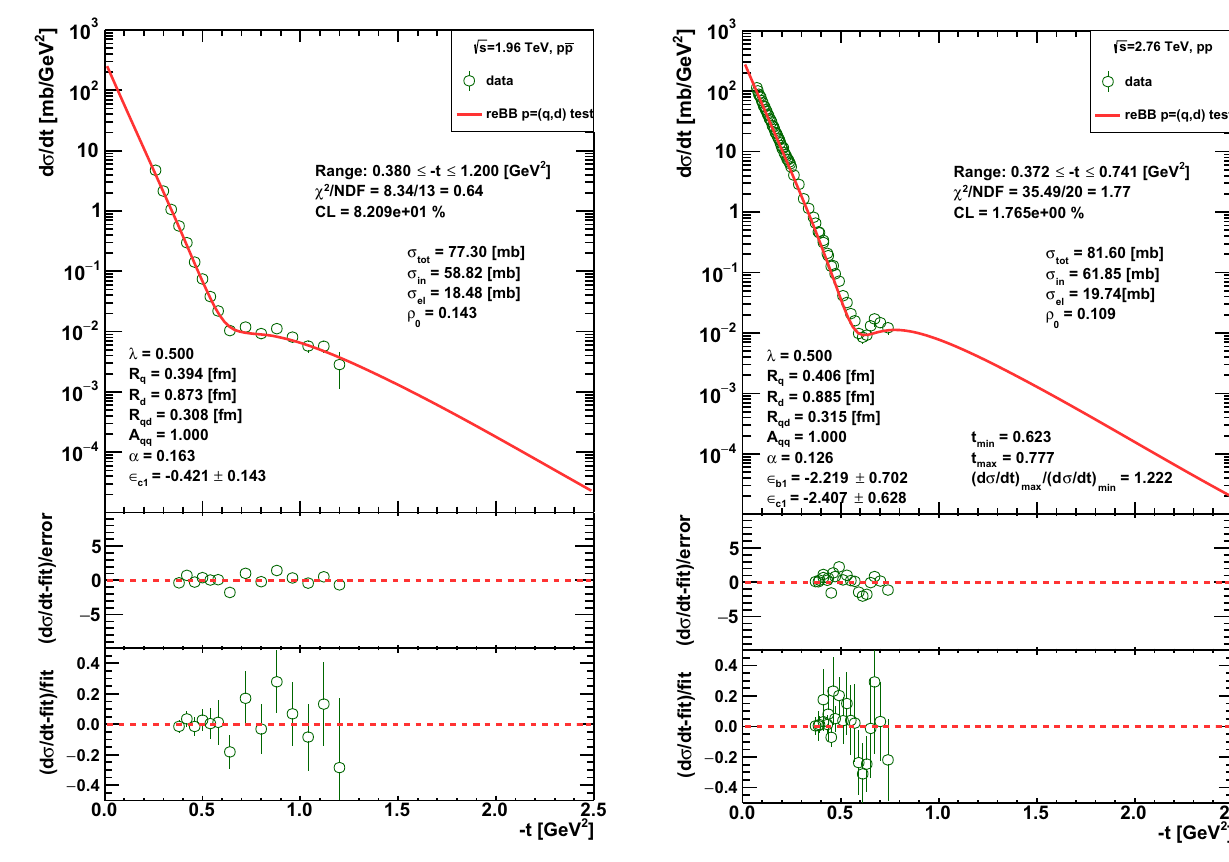
Fig. 11 Result of a sanity test, same as Fig. 8, but for the TeV p ¯ p elasticdifferentialcrosssectiondata[45]intherangeof0 . 37 ≤ − t ≤ 1 . 2 GeV 2